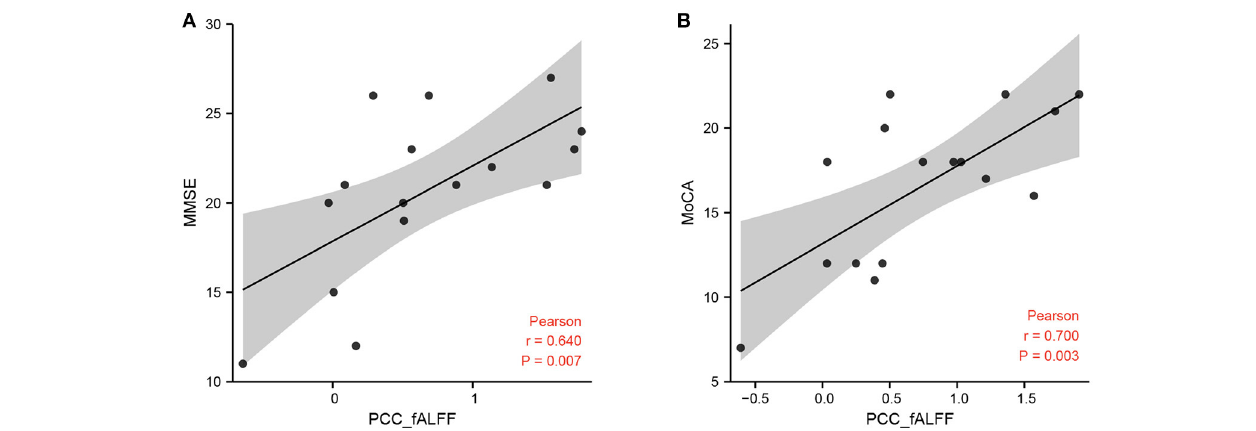
FIGURE 3 | Correlation between fALFF and MMSE, MoCA scores. (A) Correlation between the fALFF value of the left PCC and MMSE scores in cognitive impairment group after hemorrhagic stroke (hPSCI group). (B) Correlation between the fALFF value of the left PCC and MoCA scores in hPSCI group. fALFF, fractional amplitude of low-frequency fluctuations; MMSE, Mini-Mental State Examination; MoCA, Montreal Cognitive Assessment Scale.